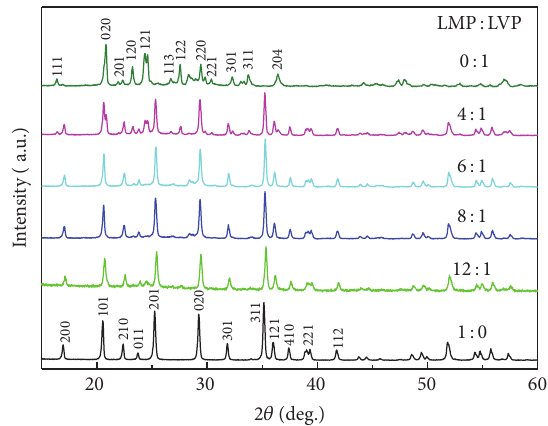
Figure 1: XRD patterns of the x LMP ⋅ y LVP/C